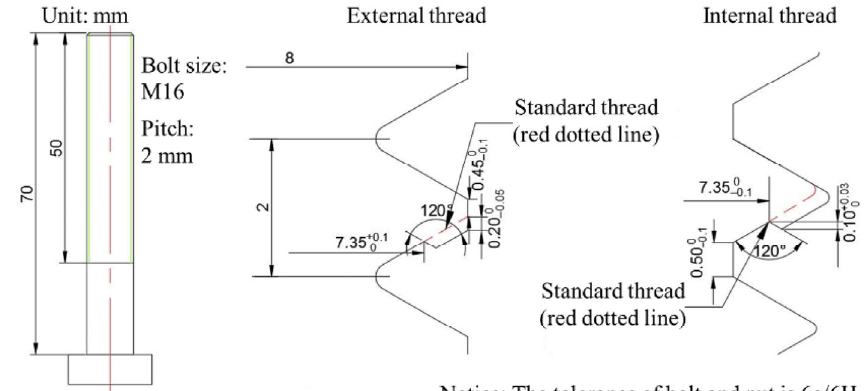
Fig. 18 Design drawing of step internal and external